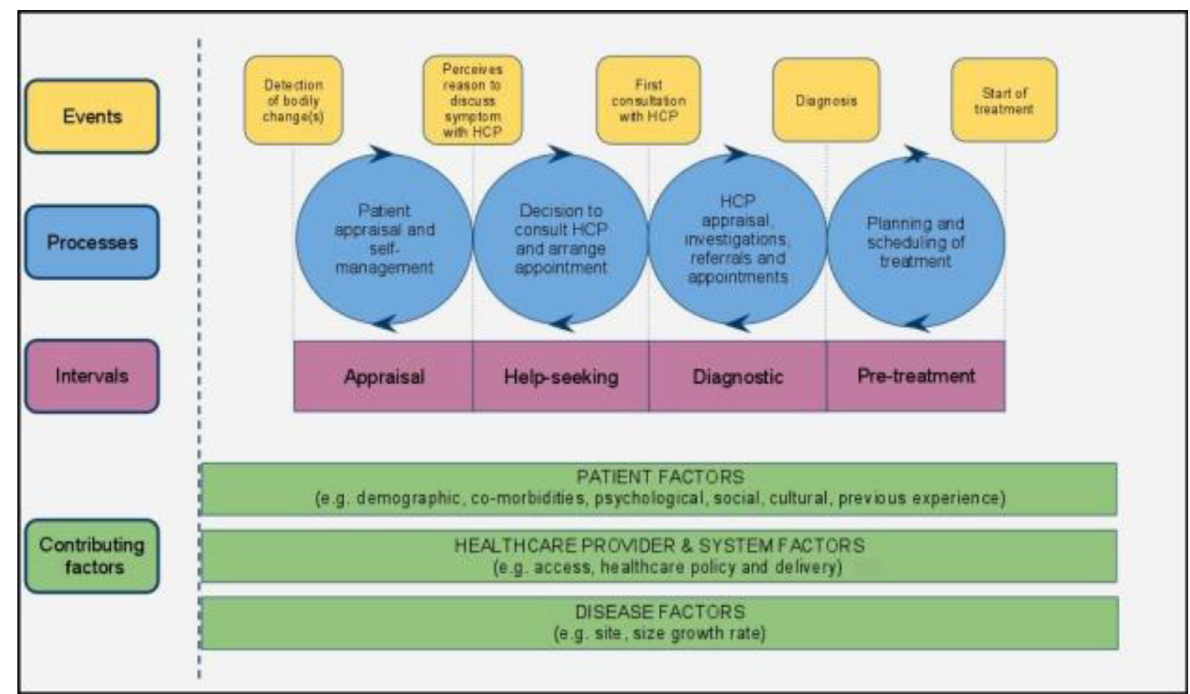
Fig 1. Model of pathways to treatment health care provider